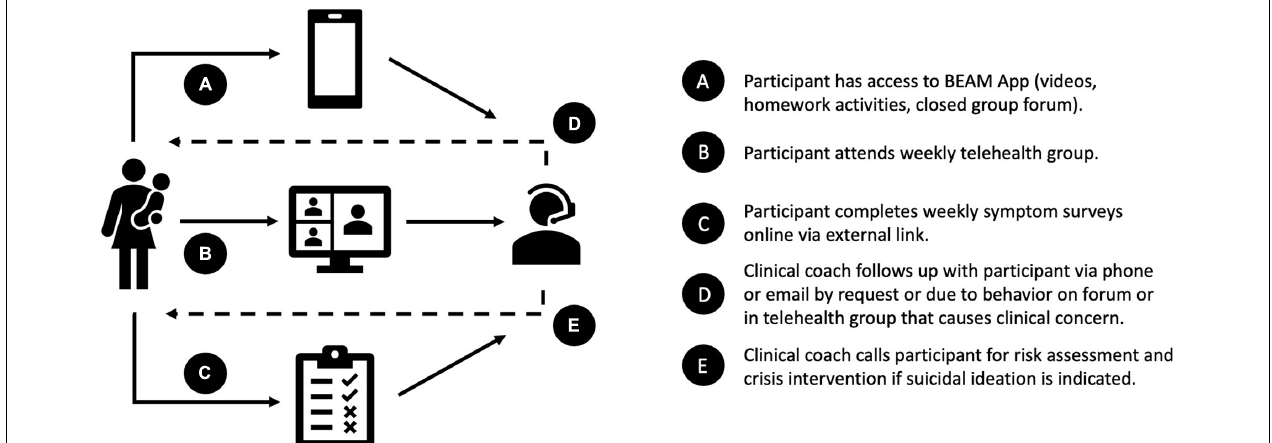
FIGURE 1 | BEAM program